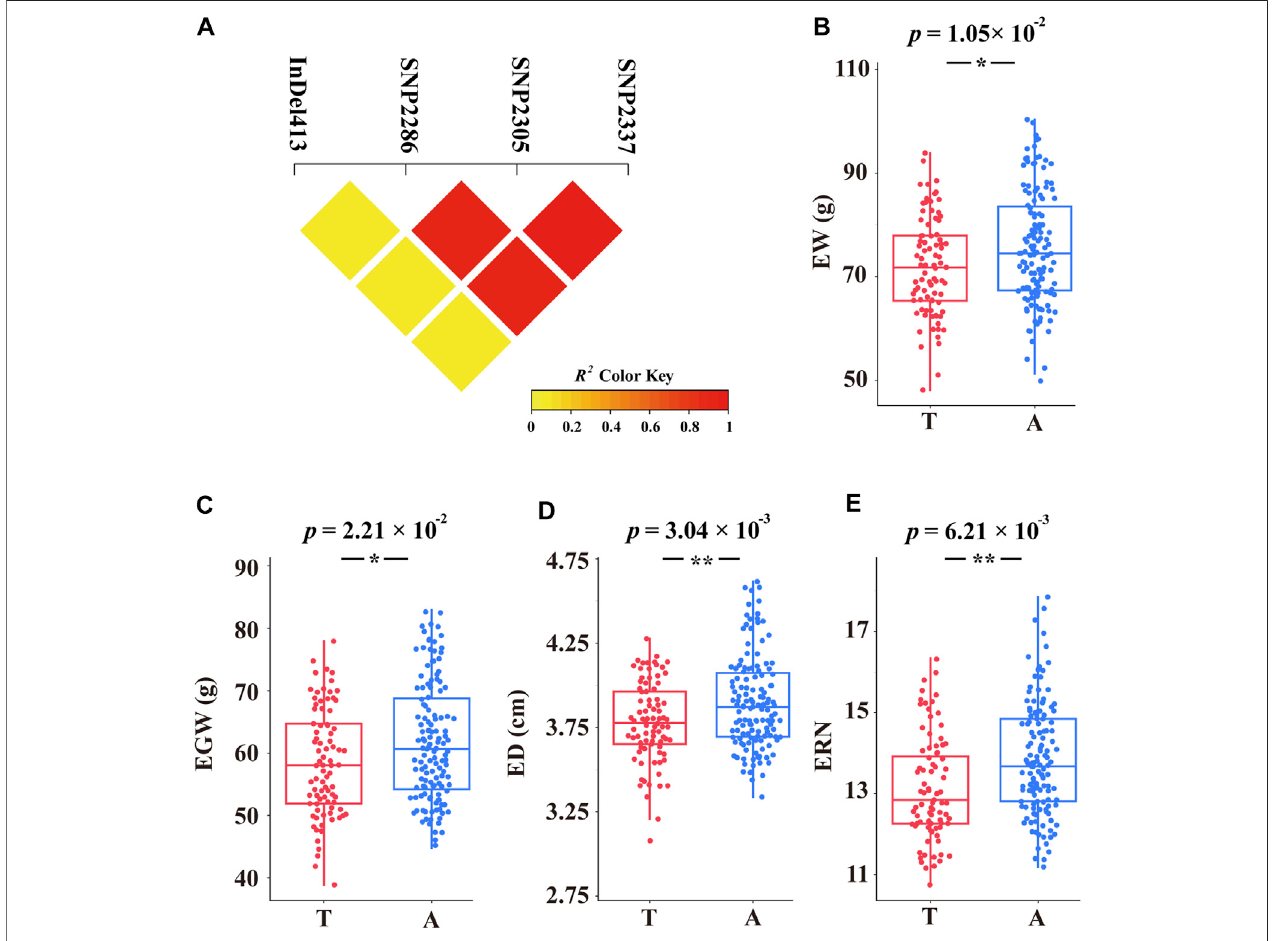
FIGURE5| Natural variationsin ZmCNR13 weresigni fi cantlyassociatedwithfourear-relatedtraits. (A) LDheatmapforfoursigni fi cantvariantsassociatedwithear traits. (B – E) Comparison ofEW, EGW,EDandERN betweendifferentallelesofSNP2305. p valuefor t testcomparing twogroupscarryingdifferentalleleswereindexed on the top (**, p < 0.01; *, p <